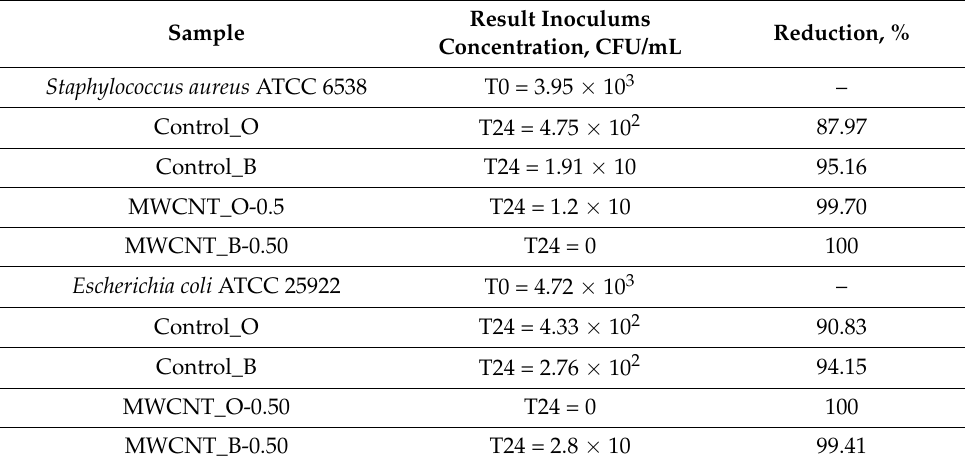
Table 4. Antimicrobial properties of bovine and sheepskin leathers treated with MWCNTs. Result Sample